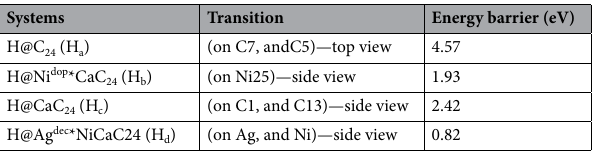
Table 6. Activated complex barrier energy in adsorption processes of the studied